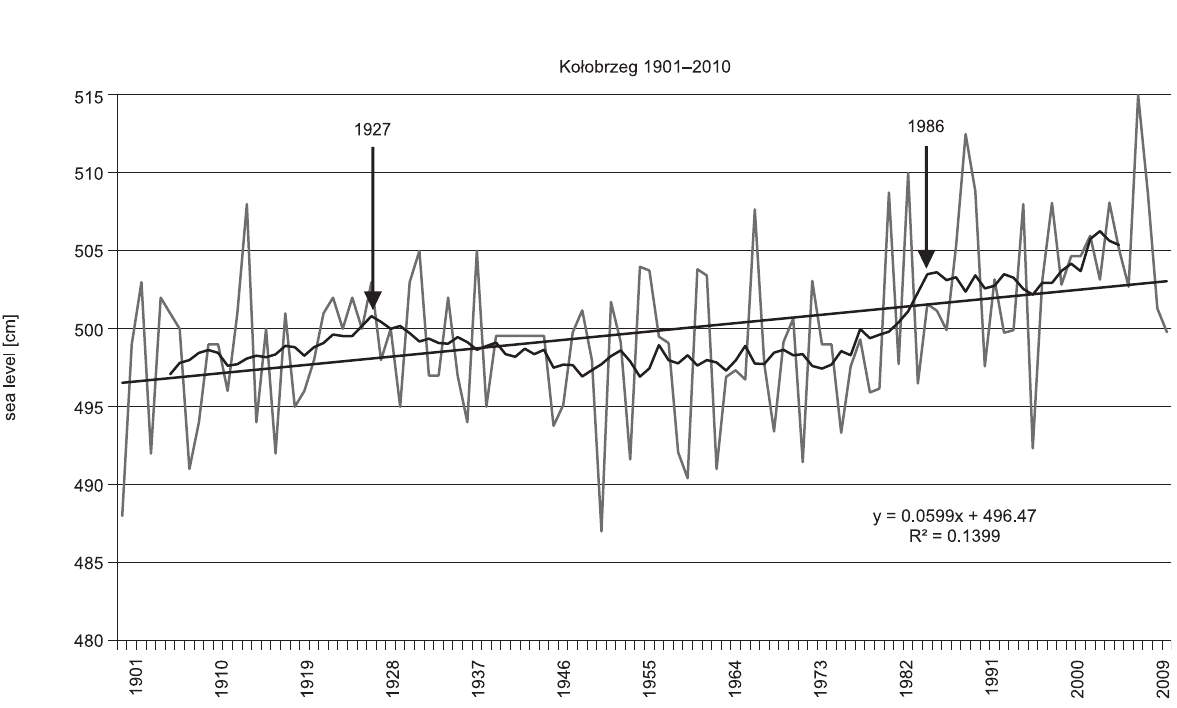
Fig. 9. Changes of the mean sea level in Kołobrzeg in 1901–2010 (the straight line represents the linear trend; the curve repre- sents the 11-yr moving average)